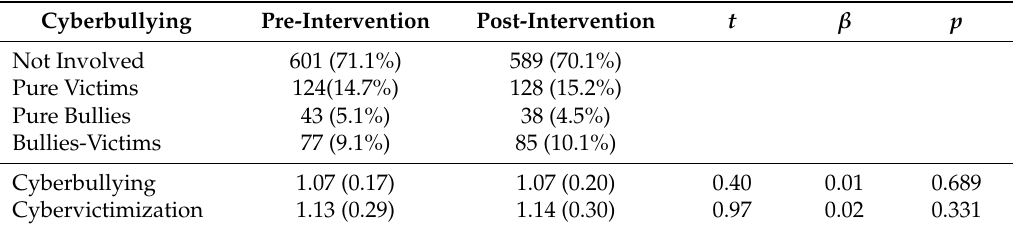
Table 1. Cyberbullying and cybervictimization before and after the intervention.